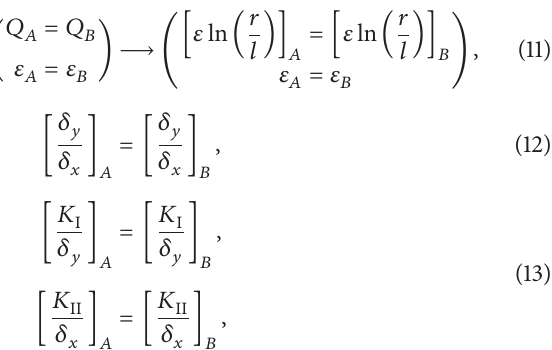
shown in (11) and (12), then the stress intensity factors 𝐾 I , 𝐾 II exhibit a proportional relationship with 𝛿 𝑦 , 𝛿 𝑥 as depicted in (13). The relative crack opening displacement values 𝛿 𝑦 and 𝛿 𝑥 can be computed by FE analysis, assuming one of the two problems is analytically well solved in advance; 𝐾 I and 𝐾 II of Problem 𝐴 are given in advance, and then the SIFs of Problem 𝐵 can be easily obtained from (13).